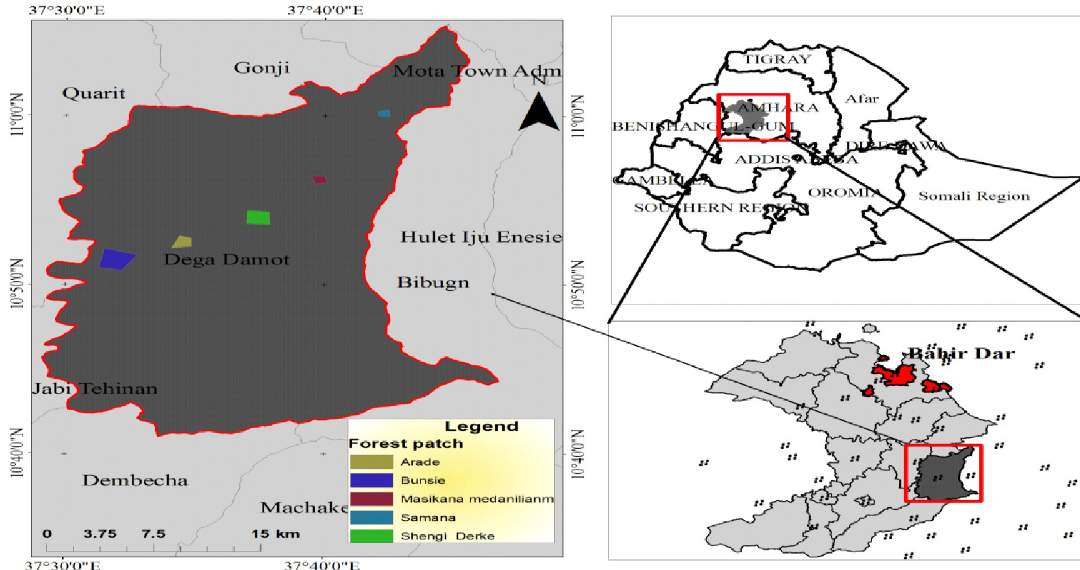
Fig 1. Location of forest patches in Dega Damot district, the star shows the small towns in the zone and in the district. Our study does not need to supply a copy right notice for Fig 1. Because the location map of the study area (Fig 1) shape file data was obtained from Ethiopian Mapping Agency (https://africaopendata.org/dataset/ethiopia-shapefiles) is free and open to researchers.